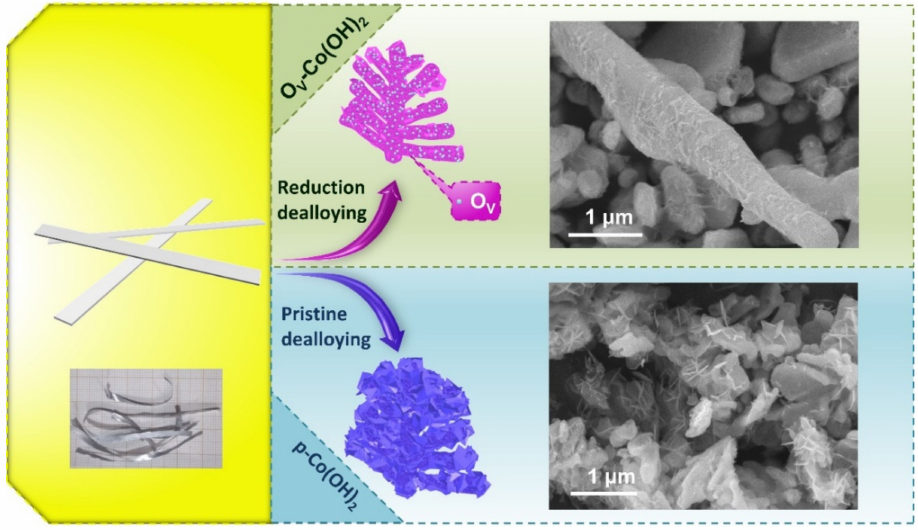
Figure 1. Schematic illustration and scanning electron microscopy images of the synthetic strategy of O V − Co(OH) 2 and p –Co(OH) 2 .